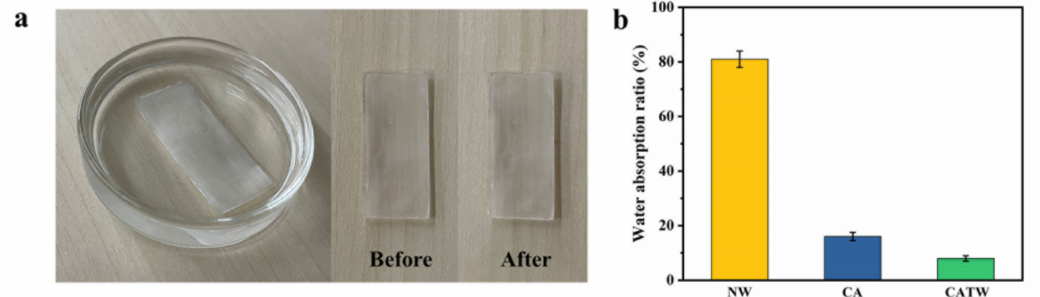
Figure 4. ( a ) Comparison of CATW samples before and after 72 h immersion in water. ( b ) Water absorption ratio of NW, CA, and